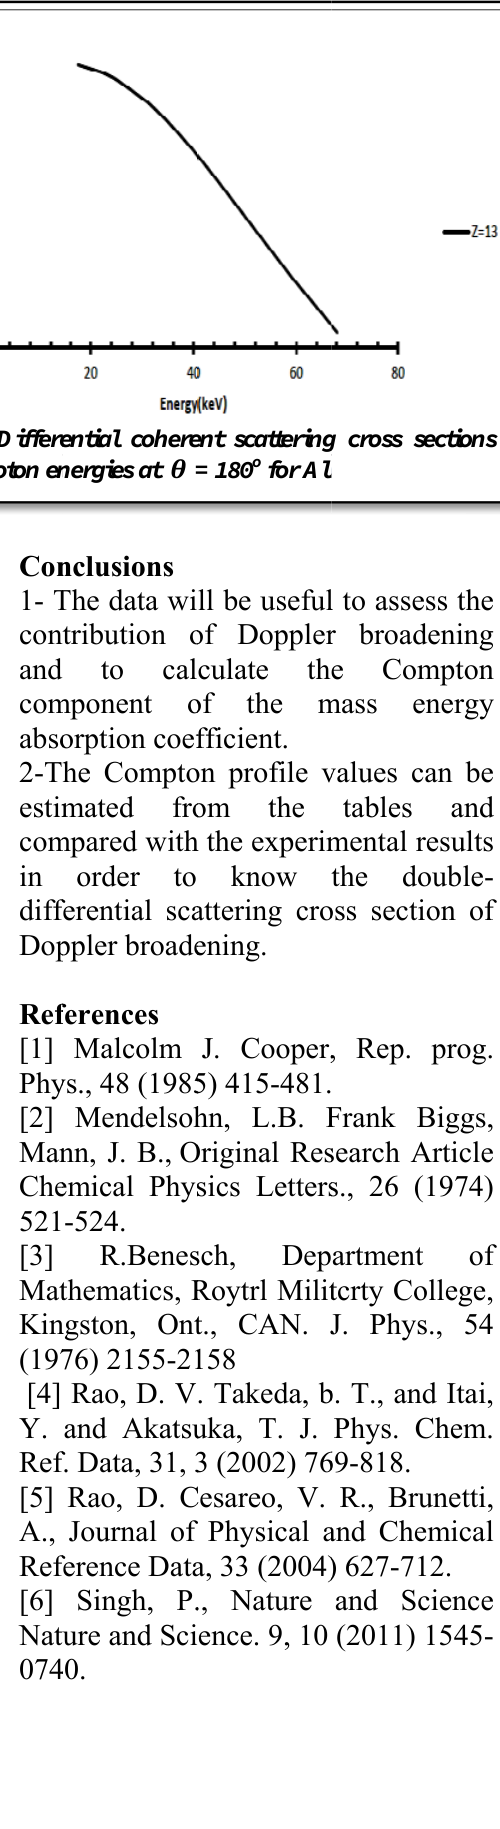
ent scattering = 180 o for Al.